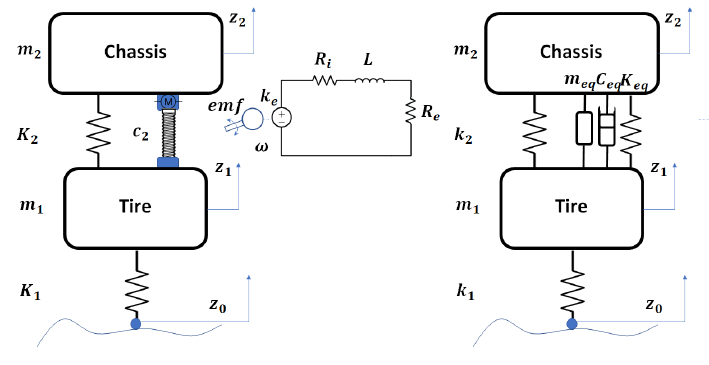
Figure 3. Breakdown of the EHSA system into equivalent parameters m eq , c eq and k eq . The shock absorber between sprung and unsprung masses is modeled as an electric generator that includes an external resistance, ball-screw, and linear spring. The damping force related to electric resistance and the input excitation to the system z were obtained, ˙ z and ¨ z represent the velocity and acceleration input,